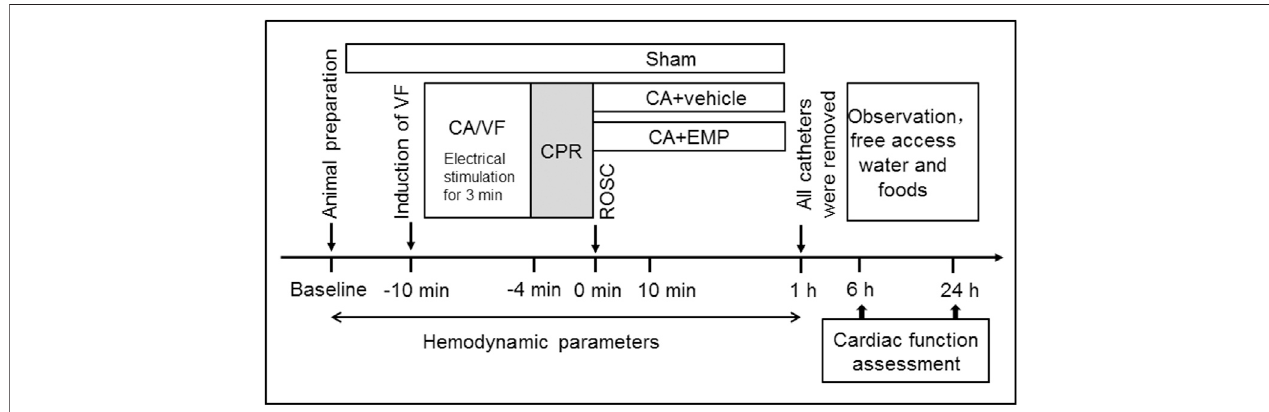
FIGURE 1 | Experimental procedures in VF-induced cardiac arrest model. VF ventricular fi brillation, CA cardiac arrest, CPR cardiopulmonary resuscitation, ROSC return of spontaneous circulation, EMP empagli fl